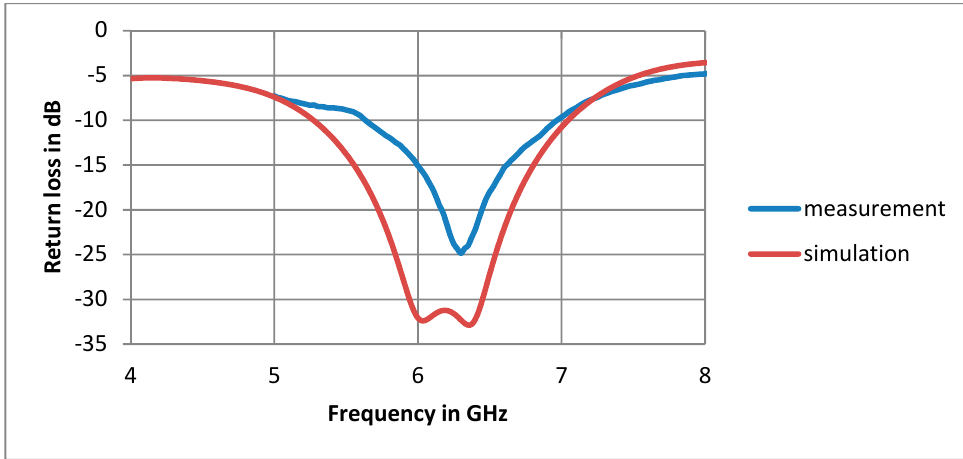
Figure 15. The simulated and measured return losses of the slot antenna (thickness = 0.508 mm).